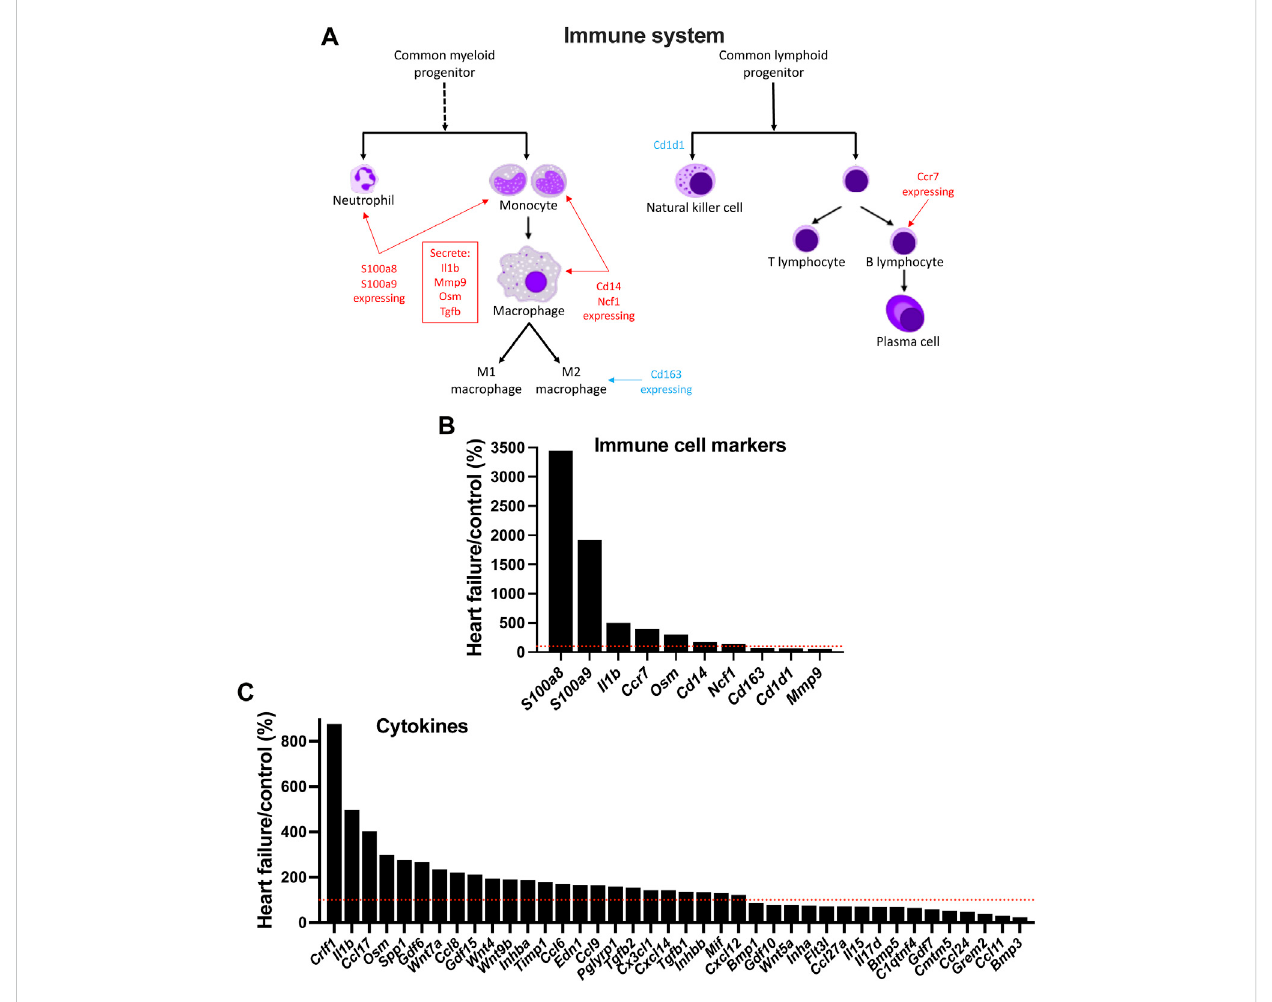
FIGURE 7 Evidence of in fi ltration of the AV node by immune cells in HF. (A) , schematic diagram of the cells of the immune system. (B) , expression of immune cell markers (transcripts) in HF mice as a percentage of that in control mice. (C) , expression of cytokine transcripts in HF mice as a percentage of that in control mice. Red dotted lines correspond to